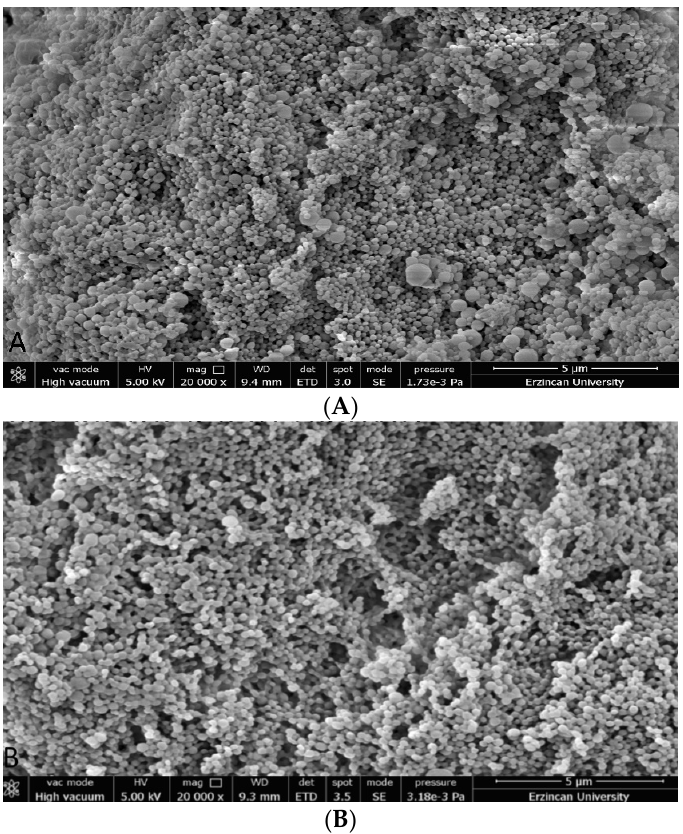
Figure 1. SEM image of PLGA NP, free nisin-loaded PLGA-NP ( A ), nisin-loaded PLGA-NP ( B ).